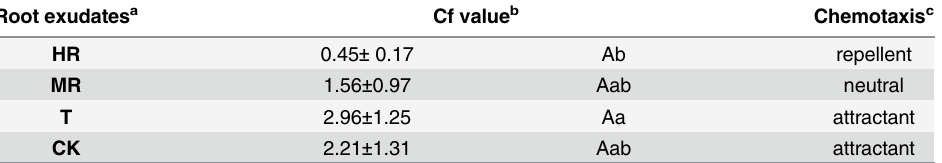
Table 1. Effects of root exudates on chemotaxis of M . incognita J2 at WA plate. Root exudates a